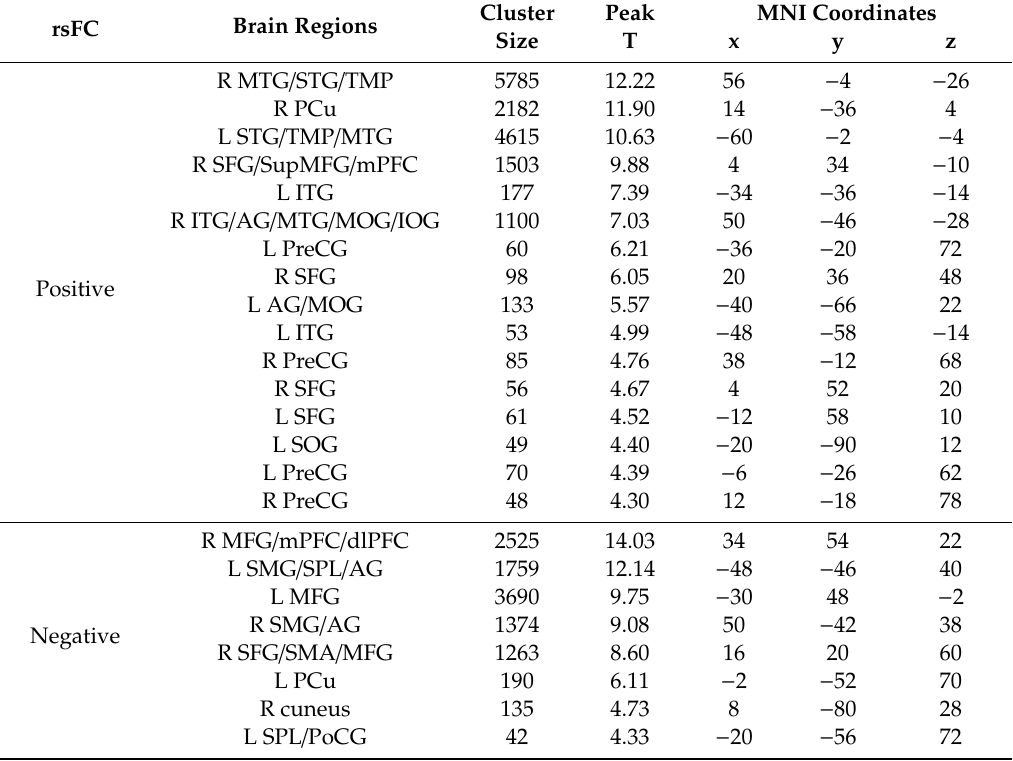
Table 3. Dementia-associated surface regions identified from R hippocampus -based resting-state functional connectivity (rsFC). rsFC Brain Regions